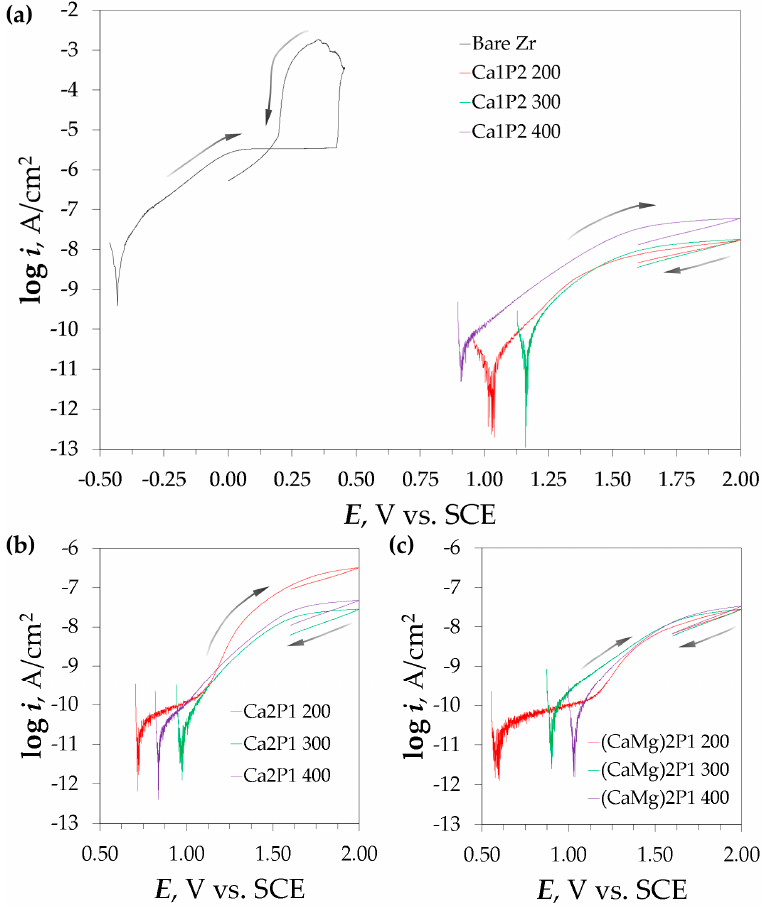
Figure 10. Potentiodynamic polarization curves recorded for the bare zirconium surface and the PEO coatings formed in Ca1P2 ( a ), Ca2P1 ( b ), as well as (CaMg)2P1 ( c ) solutions. Arrows indicate the direction of the potential scans.